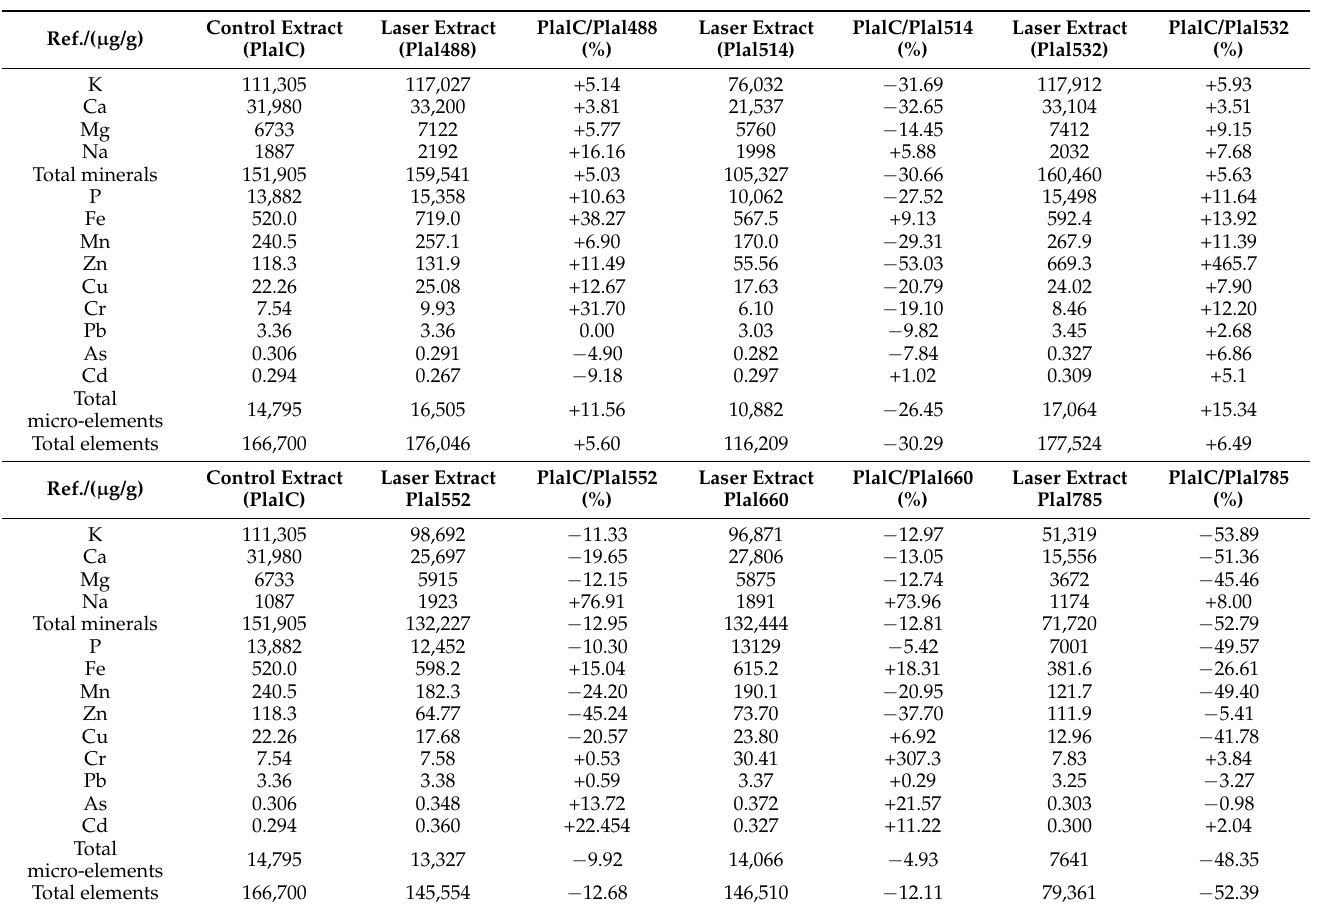
study: Figure 5a—series at 488 nm; Figure 5b—series at 514 nm; Figure 5c—series at 532 nm; Figure 5d—series at 552 nm; Figure 5e—series at 660 nm; Figure 5f—series at 785 nm. Table 2. Minerals and micro-elements content ( µ g/g plant, d.w., n = 3, mean value) in the aqueous extracts; non-irradiated extracts (PlalC) versus irradiated extracts (Plal488, Plal514, Plal532, Plal552, Plal660, and